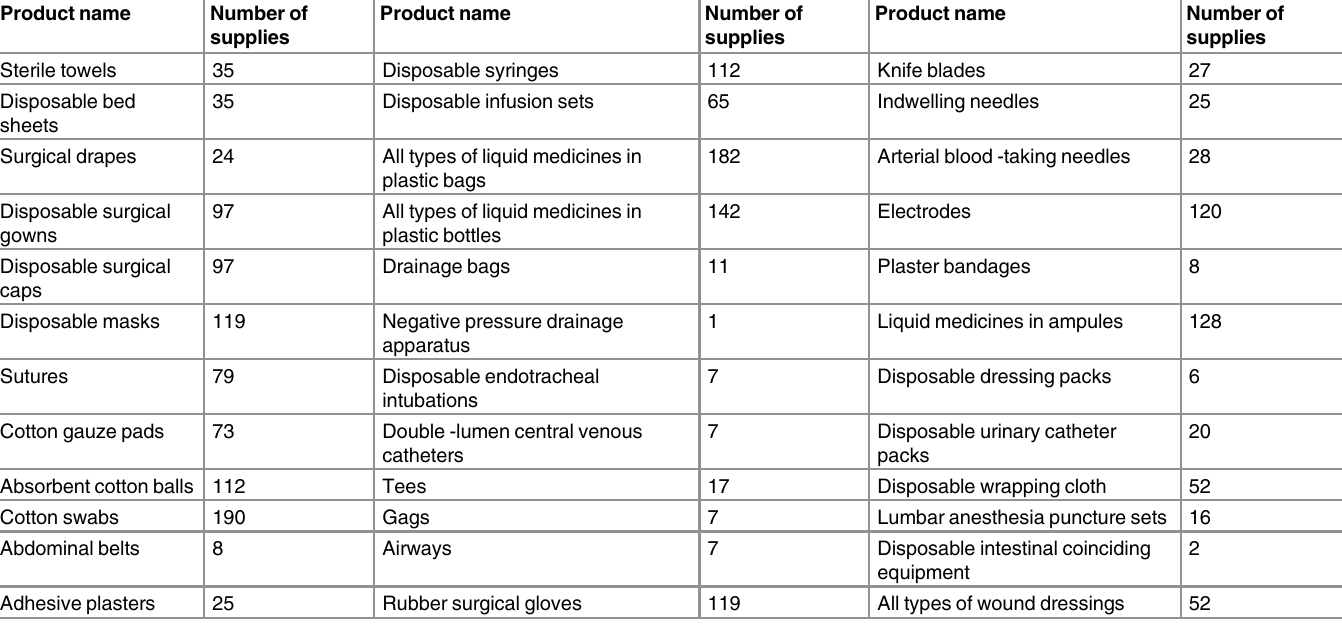
Table 2. Number of medical supplies used in 35 medical relief